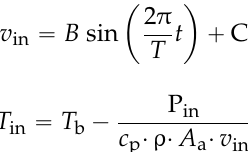
Figure 14. Time evolution of the ratio of the latent heat to the total stored heat at different inlet velocity ( Re )/inlet temperature ( Ste ) ( Re / Ste ) numbers.